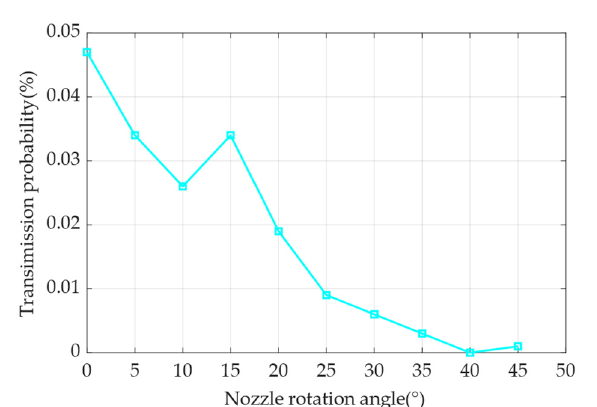
Figure 12. Relationship between nozzle rotation angle and transmission probability. The simulation results are indicated by squares in the line graph. The x-axis represents the nozzle rotation angle, which is the angle between the outer normal vector of the nozzle outlet and the x-axis in Figure 5. The y-axis represents the transmission probability, which is the ratio of the number of particles received at the sensor sampling port to the total number of particles.